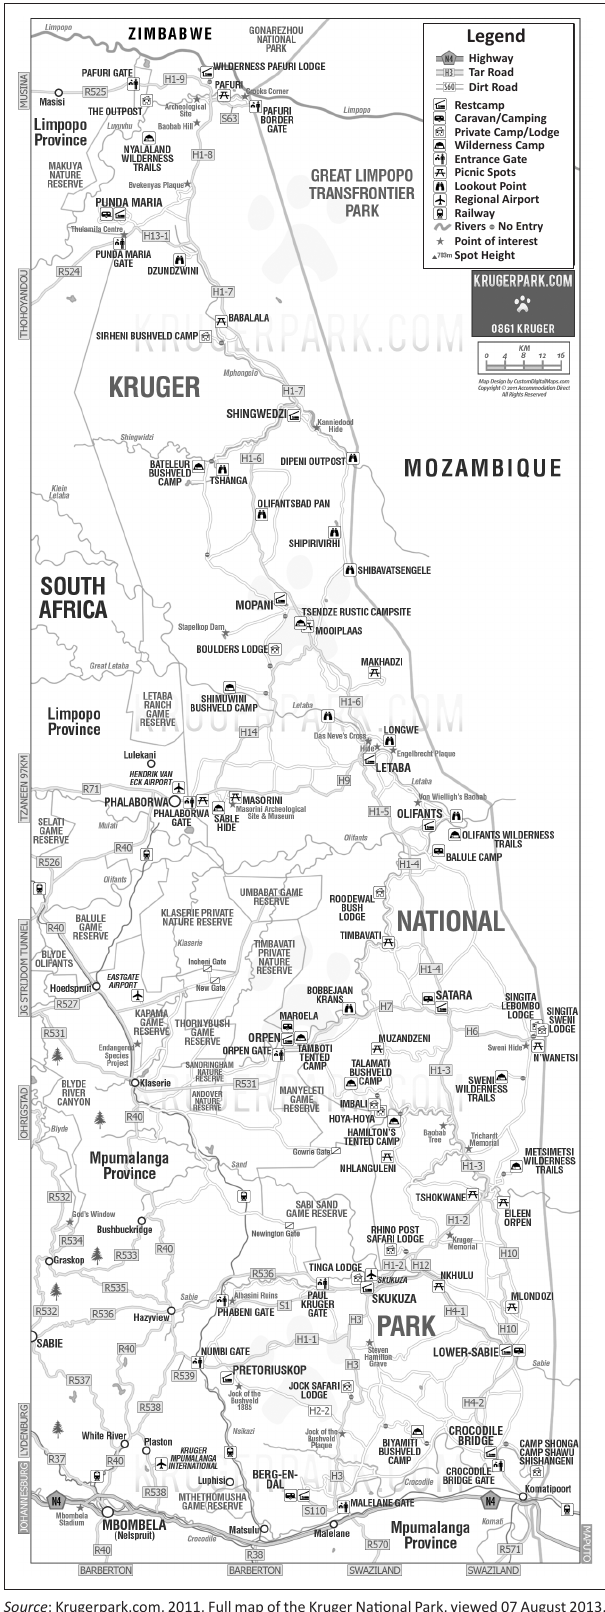
FIGURE 1: Map of the Kruger National